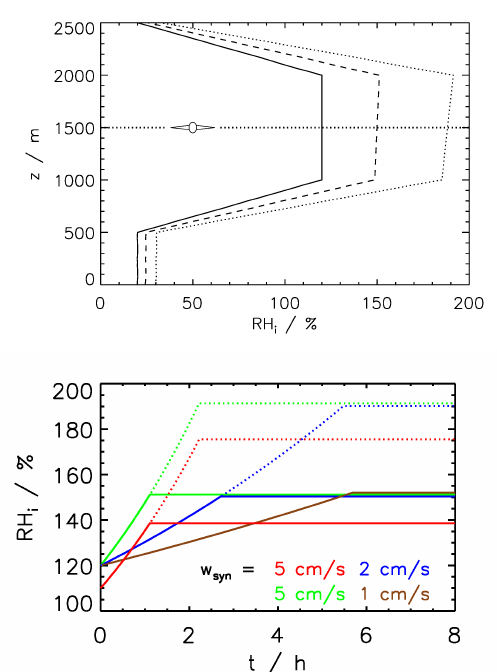
Figure 1. ( Top ): Vertical profile of the background relative humidity RH i ∗ ( z ) in the beginning (solid), after a 2K cooling (dashed) or a 4K cooling (dotted). The horizontal line at z = 1500m indicates the flight altitude of the contrail-producing aircraft. This example shows the case with RH i,0 ∗ = 120%. ( Bottom ): Temporal evolution of the background relative humidity RH i ∗ ( t ) at z = 2000m for various updraught speeds w syn = 1cm s − 1 (brown), 2cm s − 1 (blue) and 5cm s − 1 (red and green). The initial RH i,0 ∗ is either 110% or 120%. For RH i,0 ∗ = 110% only one scenario with w syn = 5cm s − 1 is displayed (red). The solid and dotted lines show scenarios with an adiabatic cooling of 2K and 4K,